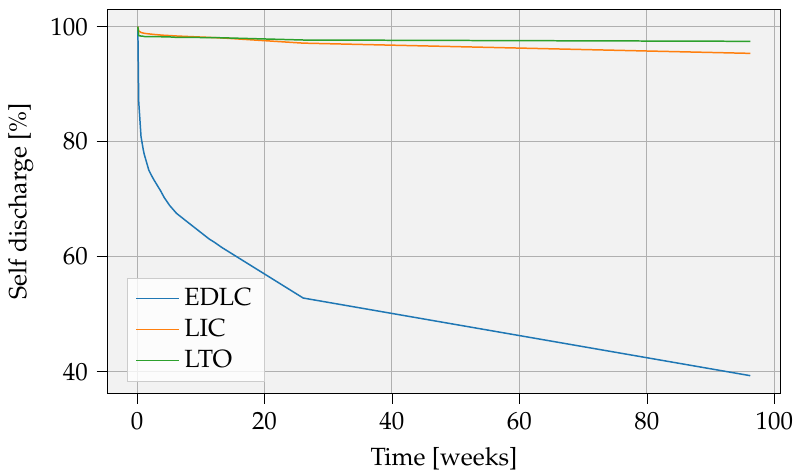
Figure 10. Self-discharge of EDLC, LIC, and LTO cells measured over approximately two years. The self-discharge is calculated as the percentage of remaining cell voltage compared with the initial voltage as a function of